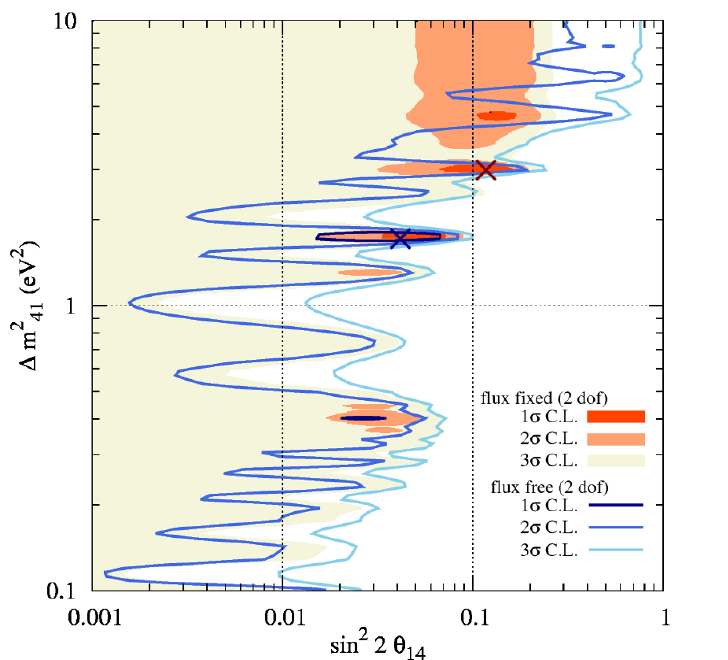
Figure 3 . Allowed regions at 1 ; 2 ; 3 (cid:27) (2 dof) con(cid:12)dence level for the combined analysis of all reactor neutrino experiments listed in table 2. For the shaded regions we take the predicted (cid:13)uxes and their quoted uncertainties according to Huber and Mueller [1, 2] at face value (\(cid:13)ux-(cid:12)xed"), while for the unshaded contour lines, the (cid:13)uxes from the four main (cid:12)ssible isotopes are allowed to vary freely (\(cid:13)ux-free"). The blue (red) cross indicates the best (cid:12)t point for the (cid:13)ux-free ((cid:13)ux-(cid:12)xed) analysis.